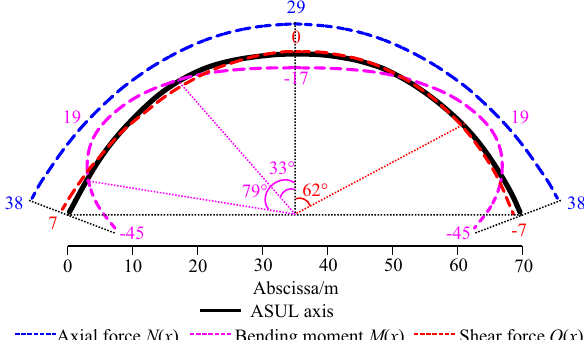
Figure 4. Internal force distribution of the ASUL (unit of force: kN, unit of bending moment: